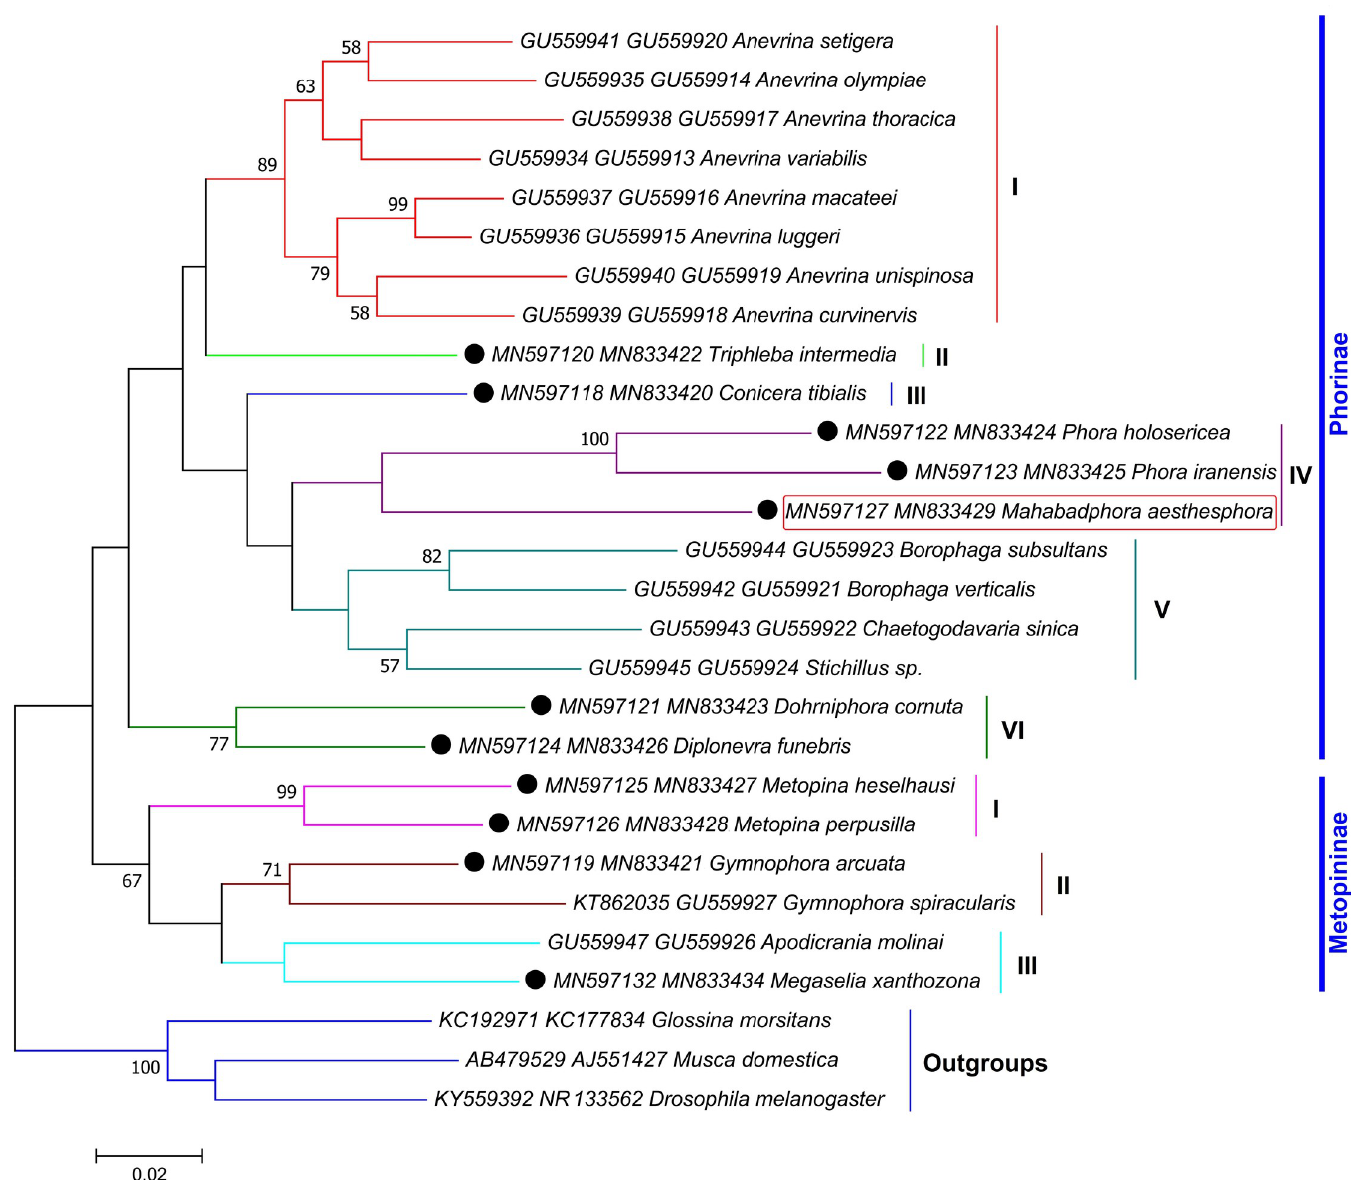
Fig 4. Maximum likelihood tree inferred from 1200–1269 bp of the COI - 28S gene sequences of 61 Megaselia species obtained in this study, along with the sequences of M . scalaris from the Genbank (KF974742-KC177721). Only bootstrap values higher than 50% are shown on the branches. The bar indicates substitutions per site. The